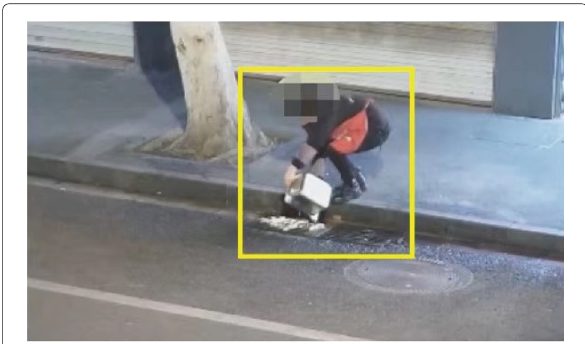
pipeline starts with an “Input” operator that accesses data on a certain device. Then a “Processing” operator is used to process the data, e.g., using AI models to make infer- ences. Finally, an “Output” operator handles the